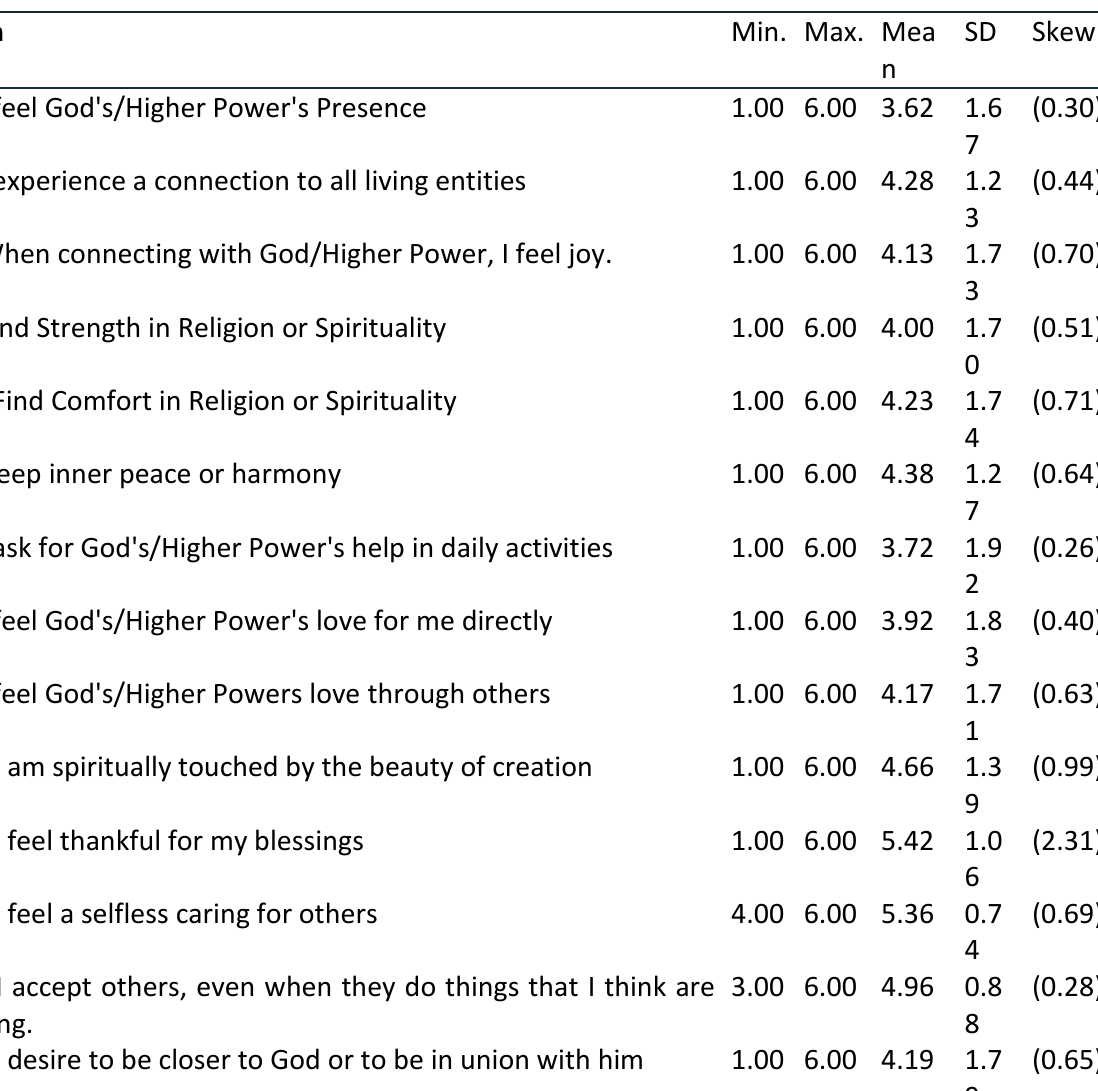
Table 1. Descriptive Statistics associated with Spirituality Items (n =